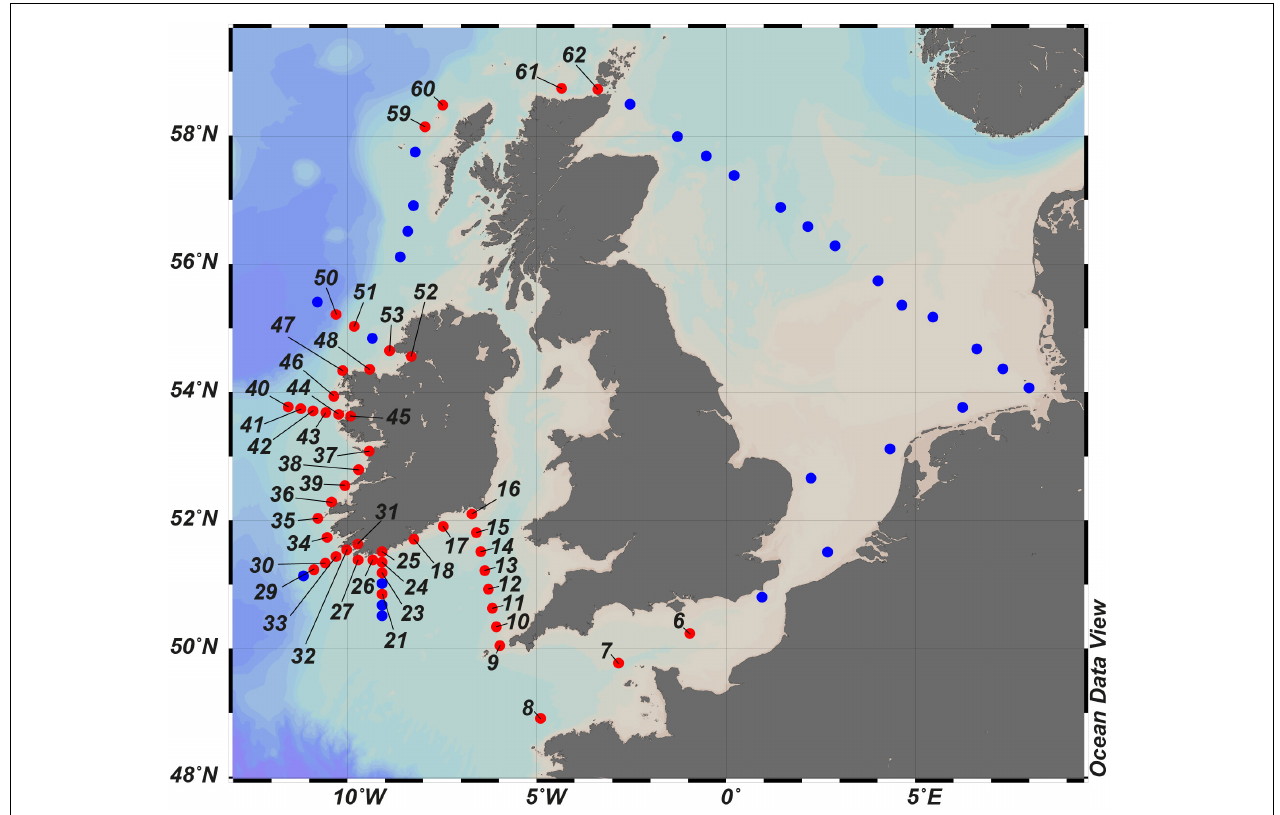
FIGURE 2 | Research area of the cruise HE516. The labeled stations marked in red are those where measurements for a comparison of the HyAbS and the PSICAM were available.